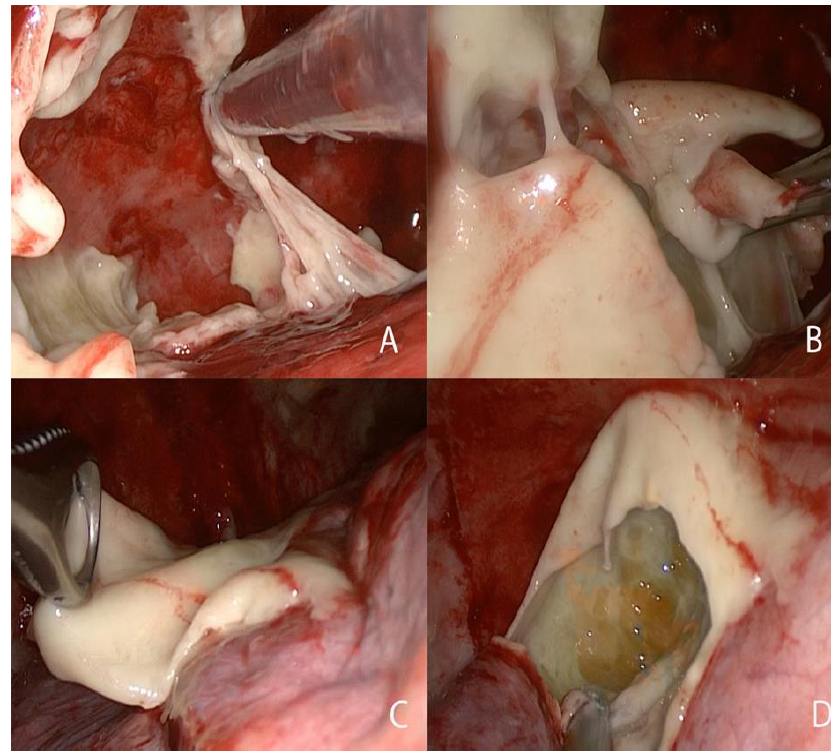
Figure 1. ( A – C ) VATS debridement and decortication. ( D ) Drainage of a pus cavity. The procedure ended with the positioning of 2 24 Fr/28 Fr drainage tubes, 1 anterior through the camera incision and 1 through the posterior incision. A digital chest drainage system (Thopaz, Medela AG, Baar, Switzerland) with suction of −20/−25 cm H 2 O was